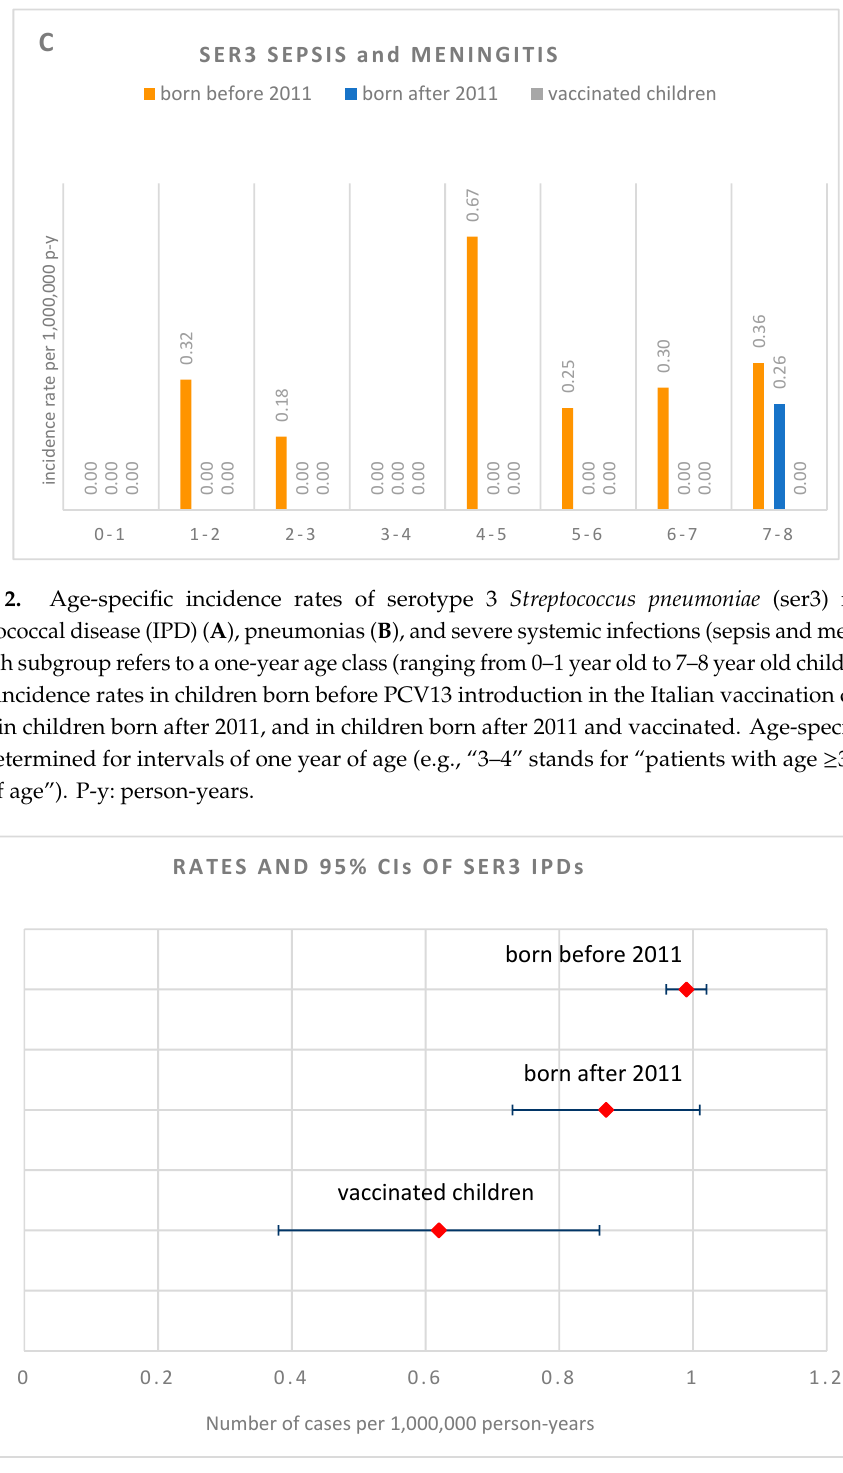
Figure 3. Incidence rates and 95% confidence intervals (CI) of serotype 3 (ser3) Streptococcus pneumoniae invasive disease (IPD) in children under 8 years of age born before PCV13 introduction in Italian vaccination calendar (2011), in children born after 2011 and in children born after 2011 and vaccinated with PCV13. Graph shows great overlap among CI and a reduction trend in ASR punctual values and CI from those born before 2011 to those born after 2011 coming to vaccinated children only. CIs are patently wider for the group of children born after 2011 and the group of vaccinated ones as adjusting rates for age, statistically augment variability.